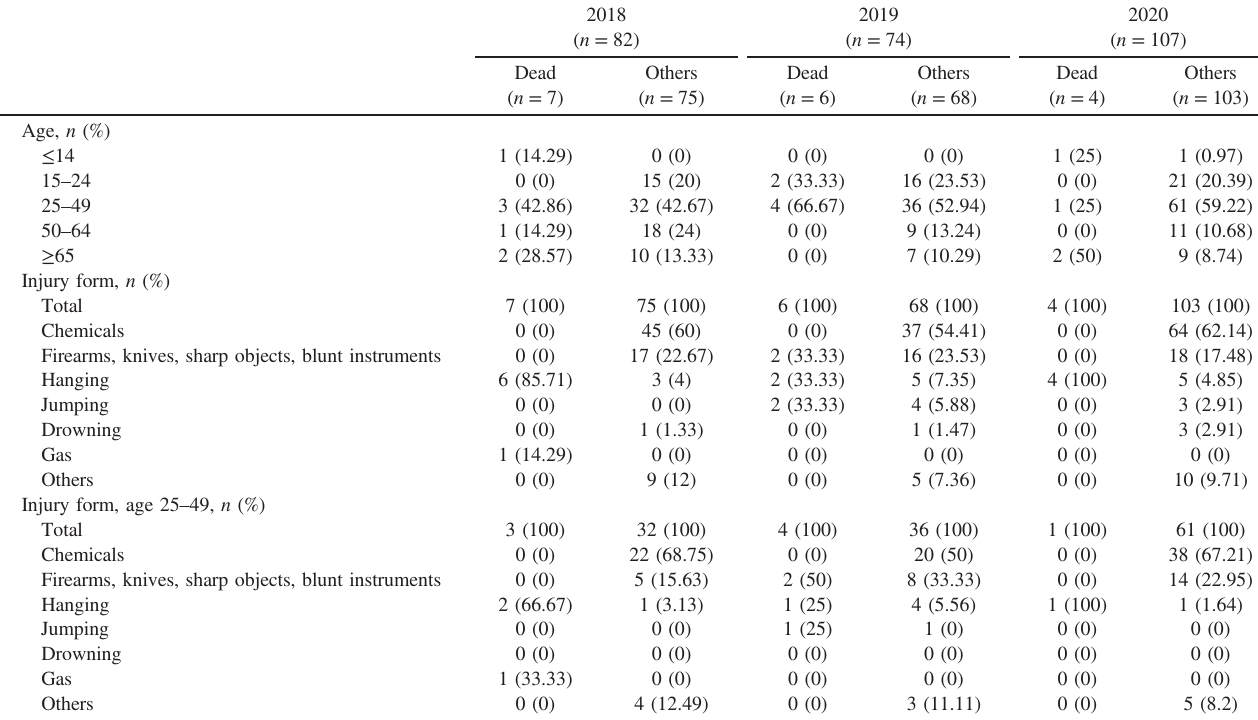
Table 4. Characteristics of suicide attempts by severity among women obtained from information on emergency dispatches in Okayama City and Kibichuo, March – August 2018, 2019, and 2020 ( n = 263)